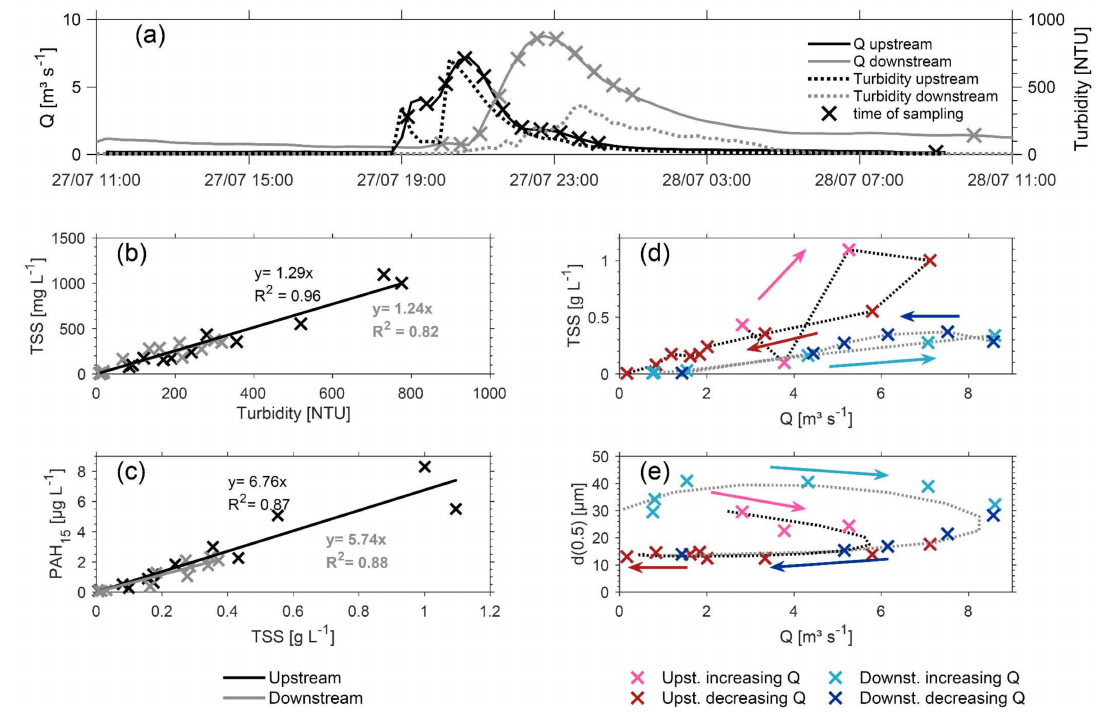
Figure 2. ( a ) Discharge ( Q ) (m 3 s − 1 ) and turbidity [NTU] during the time of the event with samples obtained during the rain event (crosses), ( b ) total suspended solids (TSS) (g L − 1 ) – turbidity [NTU] for upstream (black) and downstream (grey) sampling sites, ( c ) polycyclic aromatic hydrocarbon (PAH 15 ) concentration ( µ g L − 1 ) – TSS (g L − 1 ) relation for the upstream (black) and downstream (grey) sampling sites, ( d ) total suspended solids (TSS) (g L − 1 ) – discharge ( Q ) (m 3 s − 1 ) relation, and ( e ) median particle size (d(0.5)) – discharge ( Q ) (m 3 s − 1 ) relation. Arrows in ( d ) and ( e ) indicate the direction of the